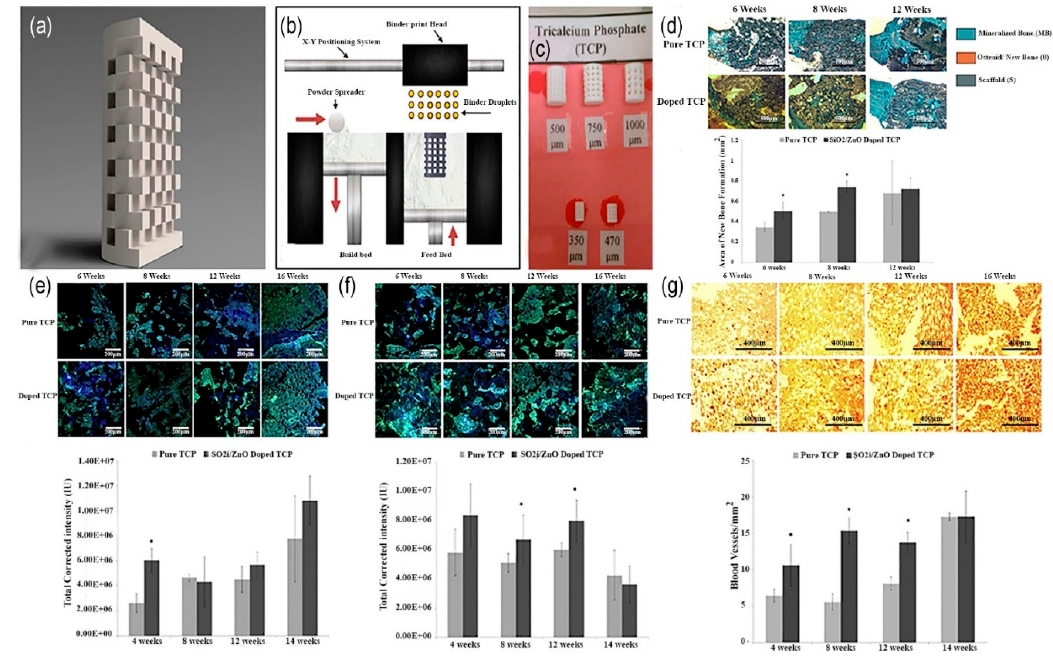
Figure 16. ( a ) CAD design used for 3D printing of porous scaffolds; ( b ) Schematic diagram illustration of 3D printing process (binder jetting); ( c ) Real 3D printed scaffolds, numbers indicating the pore size of scaffolds; ( d ) Staining of implant section via Goldner’s trichrome. Gray/brown color shows CaP implants, blue is mineralized implants and osteoid formation can be seen by orange color. Histomorphometry has done on trichrome sections (P < 0.1, where n = 3); ( e ) Confocal micrographs of collagen I formation (green) over the period of 16 weeks; ( f ) Confocal micrographs of osteocalcin (green). While blue color indicates counterstain for cell nuclei; ( g ) Light micrographs showing vWF staining (the dark red spots) [118].